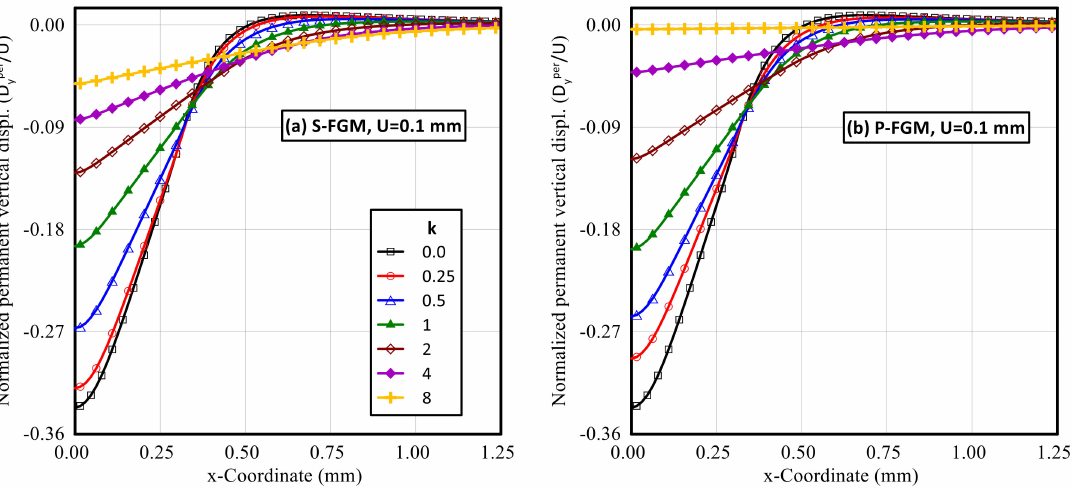
Figure 15. Profiles of the permanent vertical displacement (after unloading) along the upper surface of an elastoplastic Ti/TiB specimen at different gradient indices; ( a ) S-FGM, and ( b )